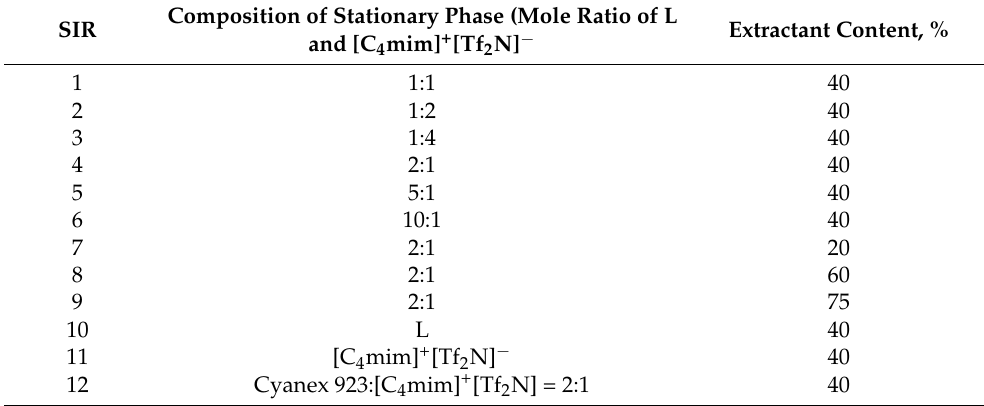
Table 5. Composition of prepared